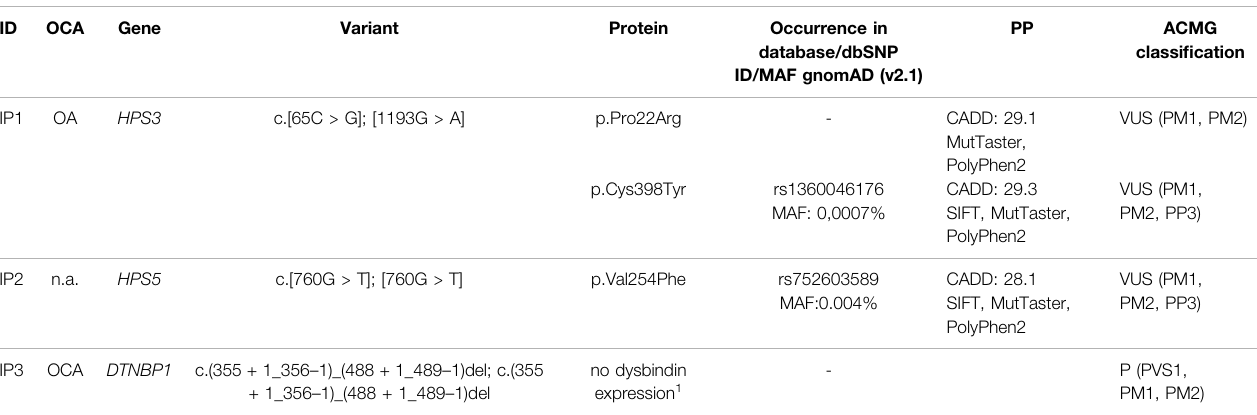
TABLE 2 | OCA phenotype and genetic variants identi fi ed using NGS for each